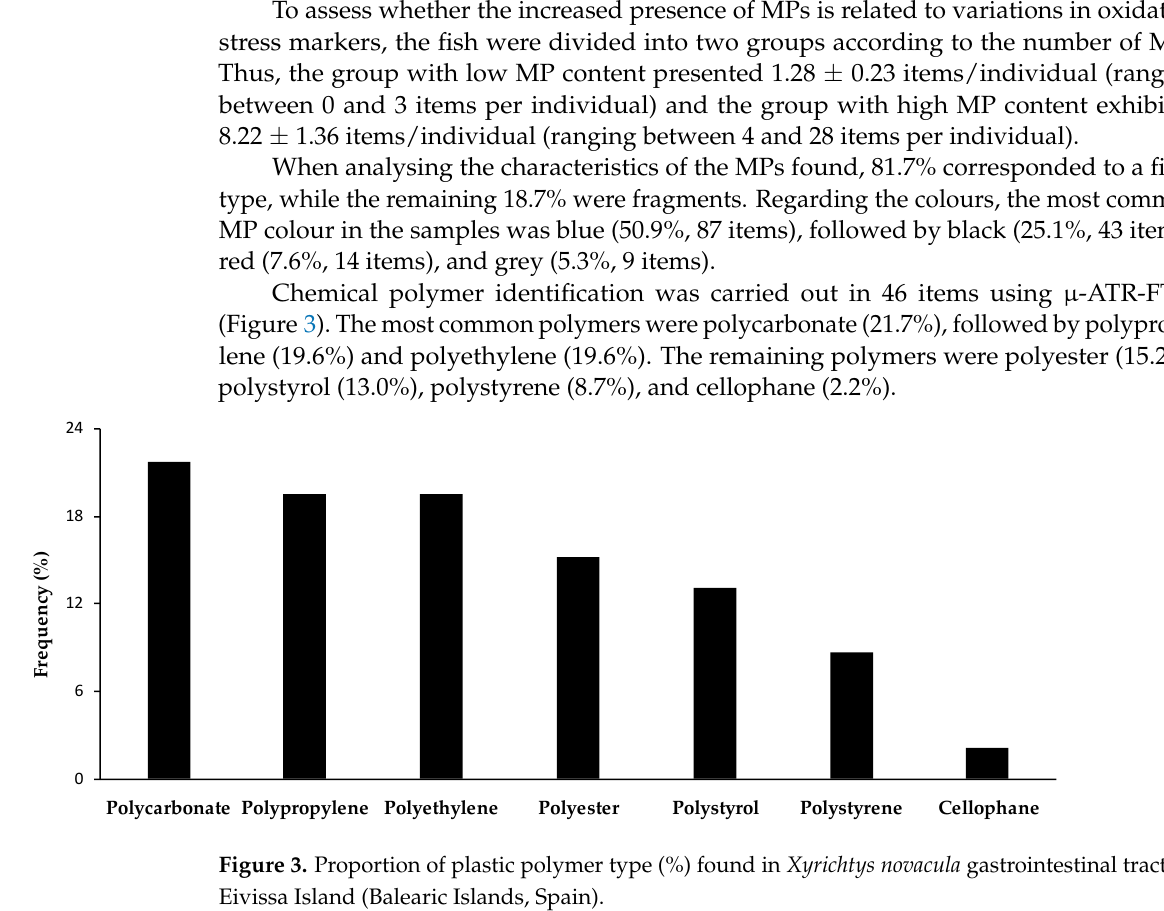
Figure 2. Representative images of a microplastic fibre ( A ) and fragment ( B ) found in the gastroin- testinal tract of Xyrichtys novacula . Scale bar represents 1 mm.